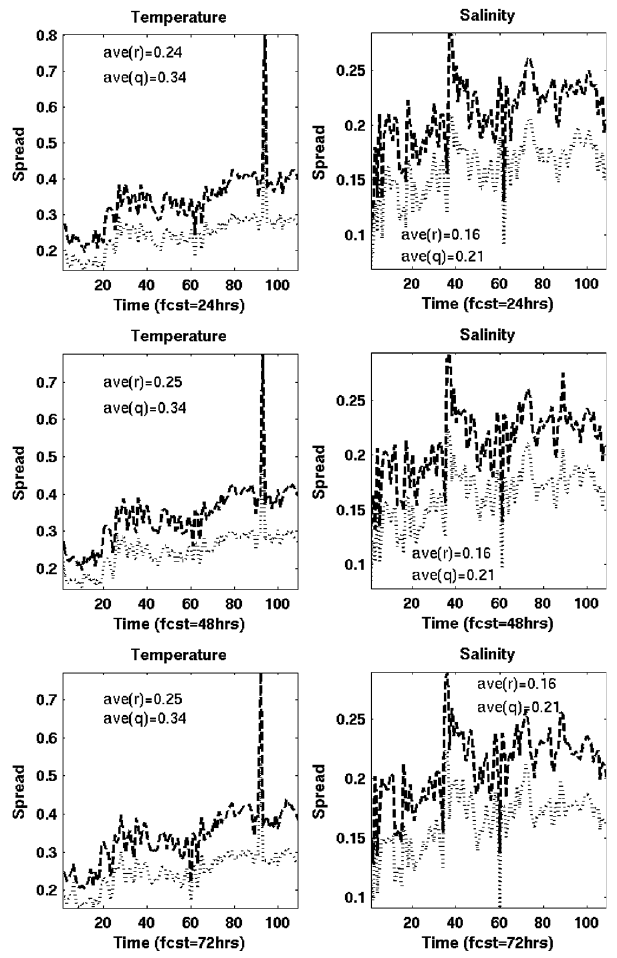
Fig. 2. Ensemble spreads for r (dotted) and q (dashed) as functions of day during the experimental period from 1 June to 17 September 2012. The spreads of T (left panel) and S (right panel) are shown for forecast lead times of 24, 48 and 72h from top to bottom panels. The spread values are averaged over the observation space between 0 and 100m.